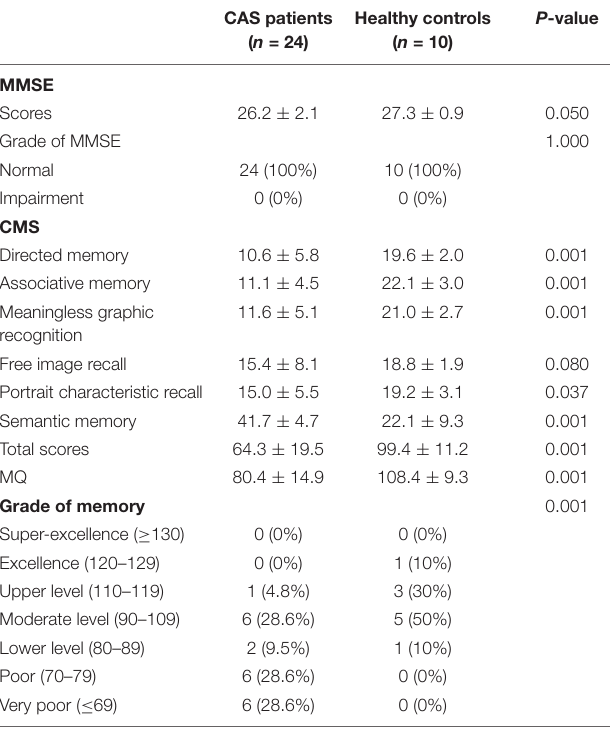
TABLE 2 | Cognitive function assessment of CAS patients and healthy controls.